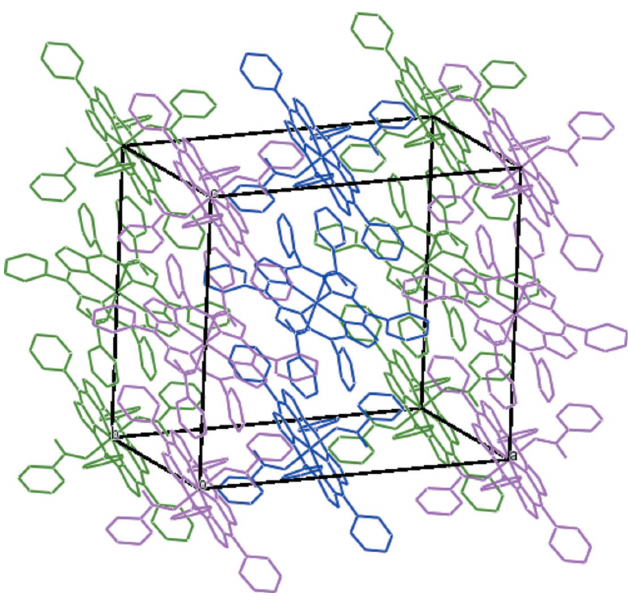
Figure 3 View of the three-dimensional packing in a view along [111]. Colour code; purple (front layer), blue (middle layer), and green (back end layer). Hydrogen atoms are omitted for